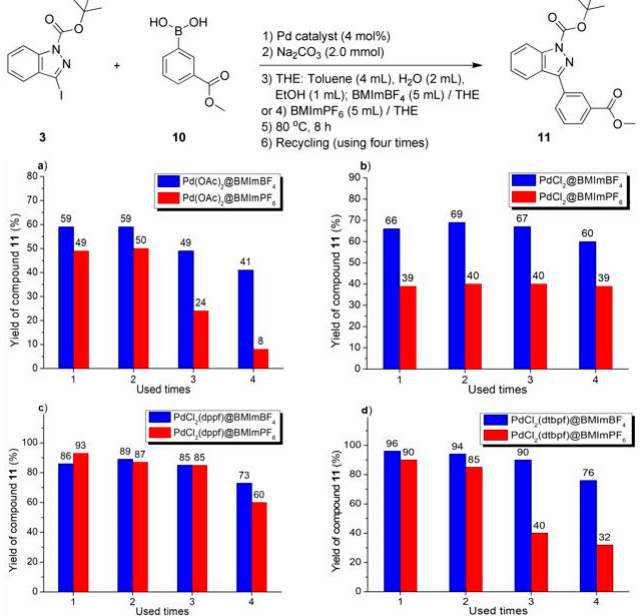
Figure 4. Recycling experiments on Suzuki–Miyaura cross-coupling of compounds 3 with 10 , cata- lyzed by Pd catalyst and immobilized over imidazolium ionic liquid: ( a ) Pd(OAc) 2 over ILs; ( b ) PdCl 2 over ILs; ( c ) PdCl 2 (dppf) over ILs; ( d ) PdCl 2 (dtbpf) over ILs.